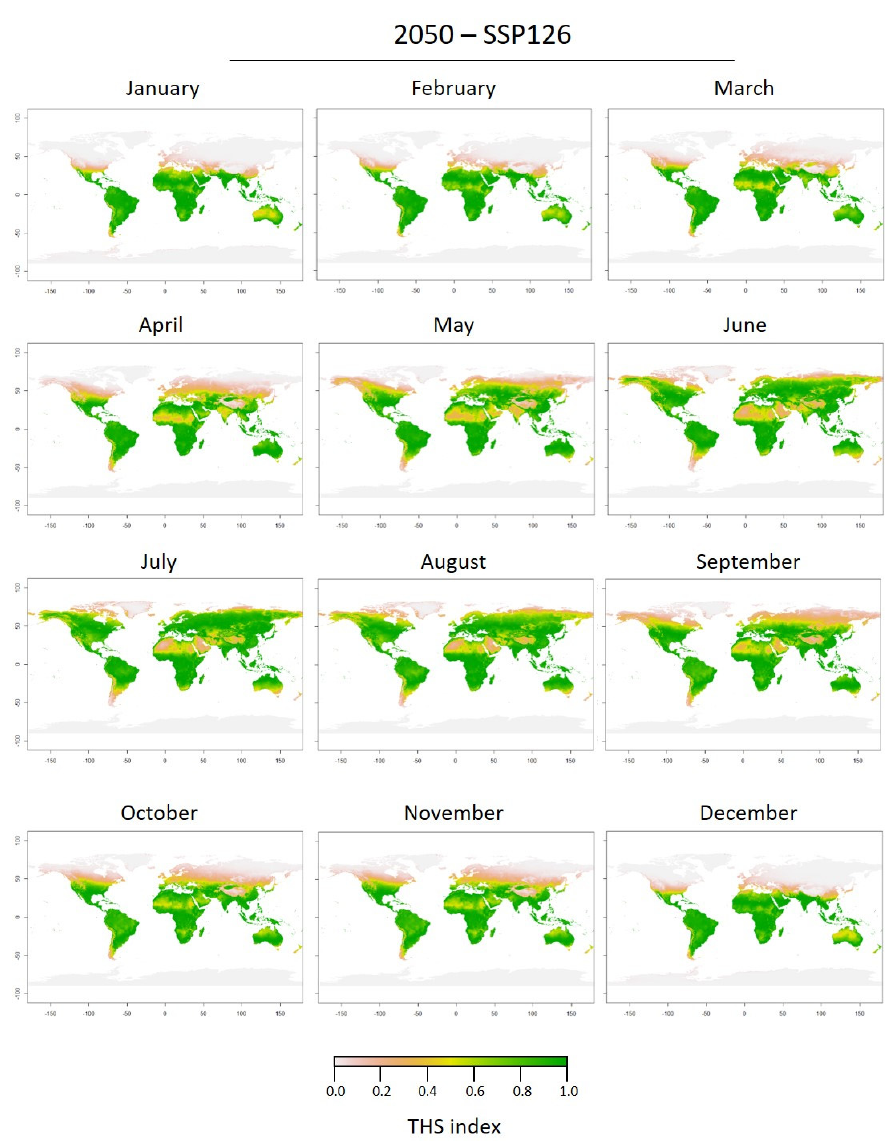
Figure 6. 2050-SSP126 monthly predictions of Thermal Habitat Suitability (THS) of the medusa stage of Craspedacusta sowerbii based on the Thermal Performance Curve (TPC) performed on the activity rate (pulsations min − 1 , lower panel).